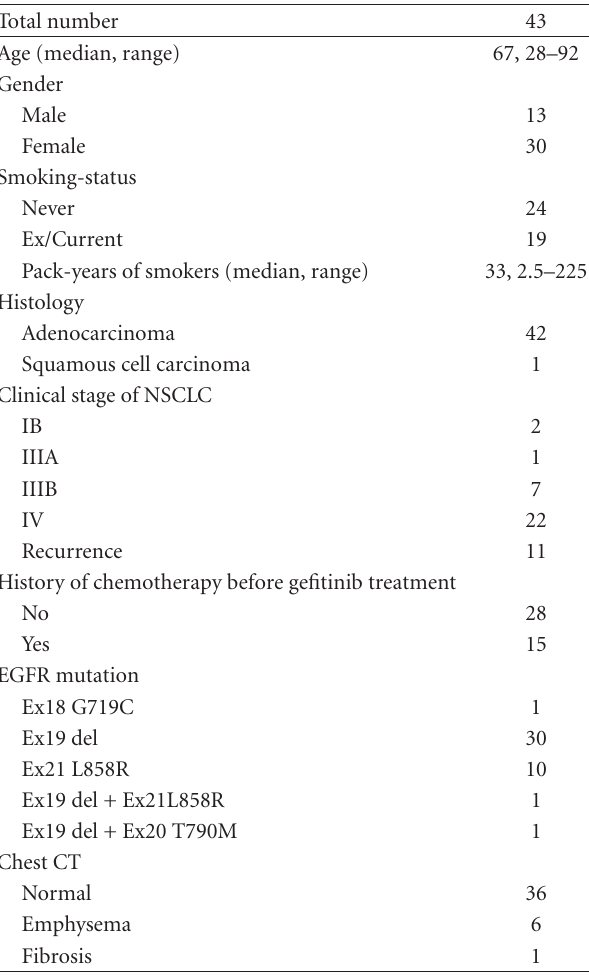
Table 3: Characteristics of patients with an EGFR mutation treated with gefitinib.